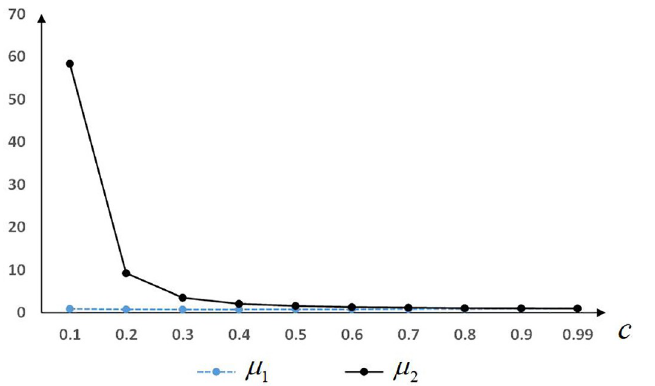
Fig 1. Relationship between μ 1 , μ 2 and the unit production cost c .